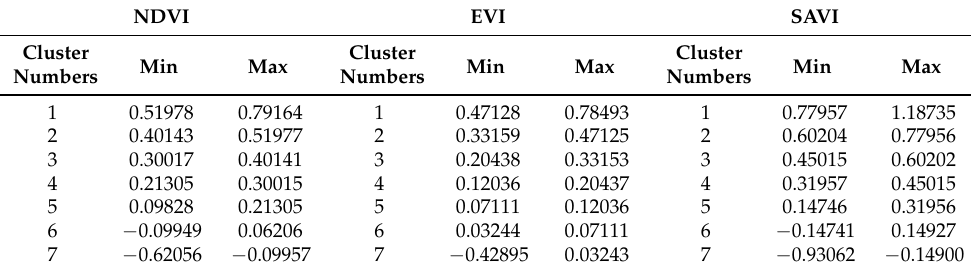
Table 6. Optimal cluster pixel range for the vegetation index.